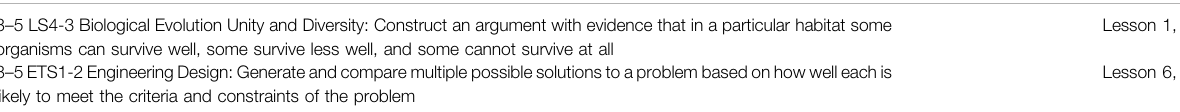
TABLE 1 | Two age-appropriate, three-dimensional (3D) performance expectations that served as the primary learning goals for the unit (from NGSS Lead States, 2013). 3D Performance Expectations for the Elementary